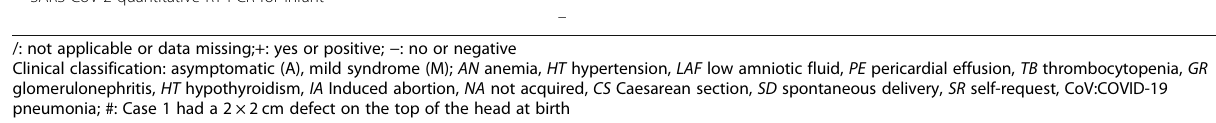
Table 1 Demographical and clinical characteristics of the recovered COVID-19 infected pregnant women (Continued) Characteristics SARS-CoV-2 quantitative RT-PCR for infant